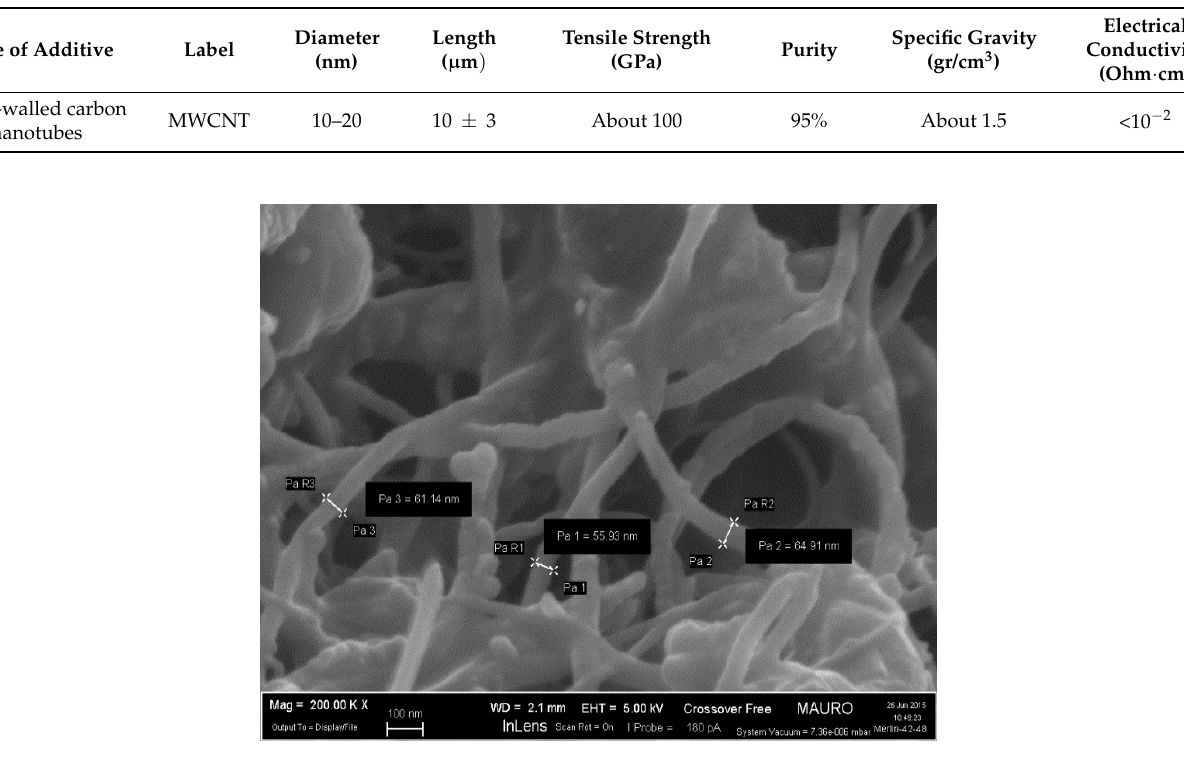
Figure 1. MWCNTs SEM images and their measured